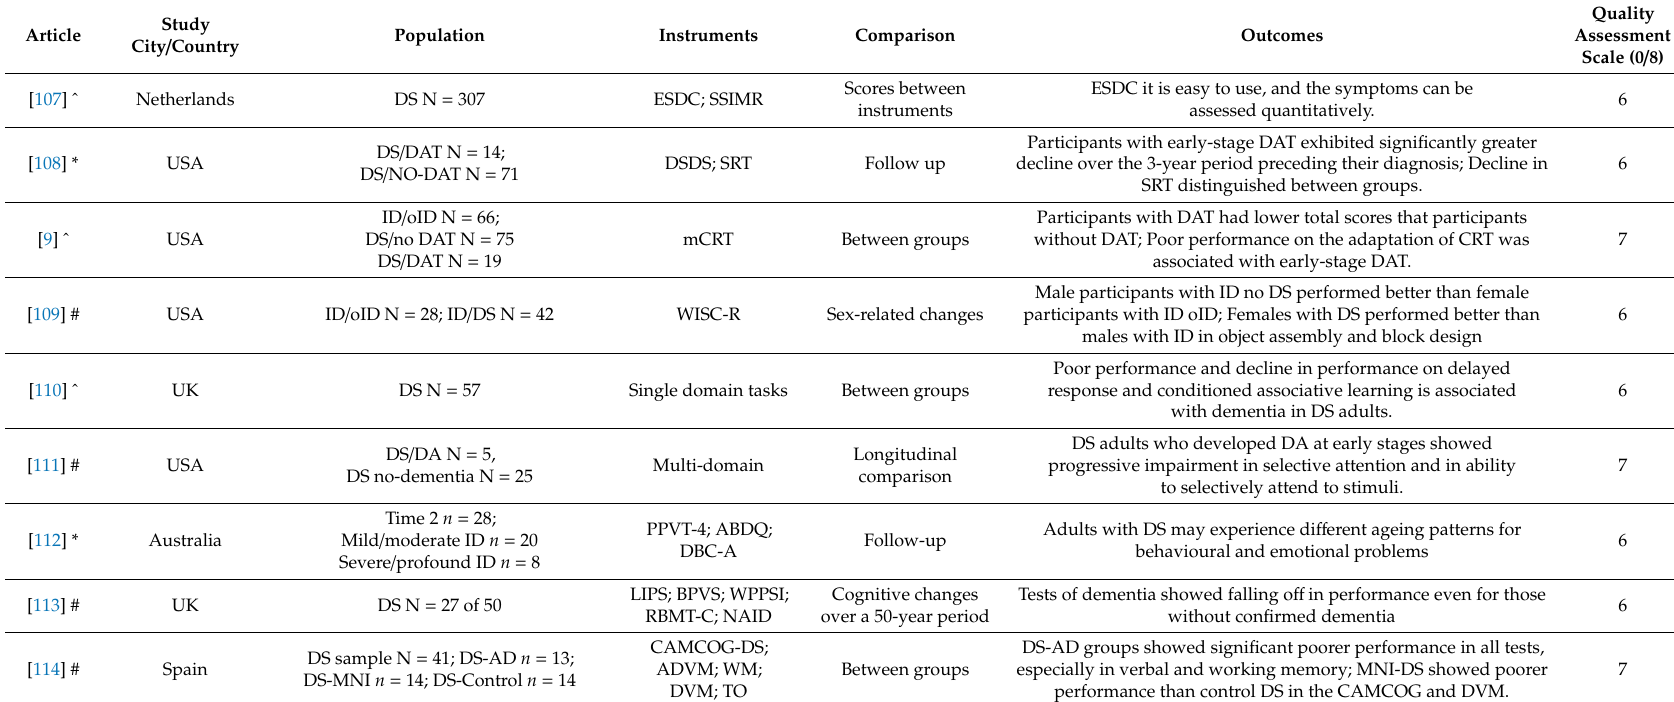
Instruments Comparison Outcomes